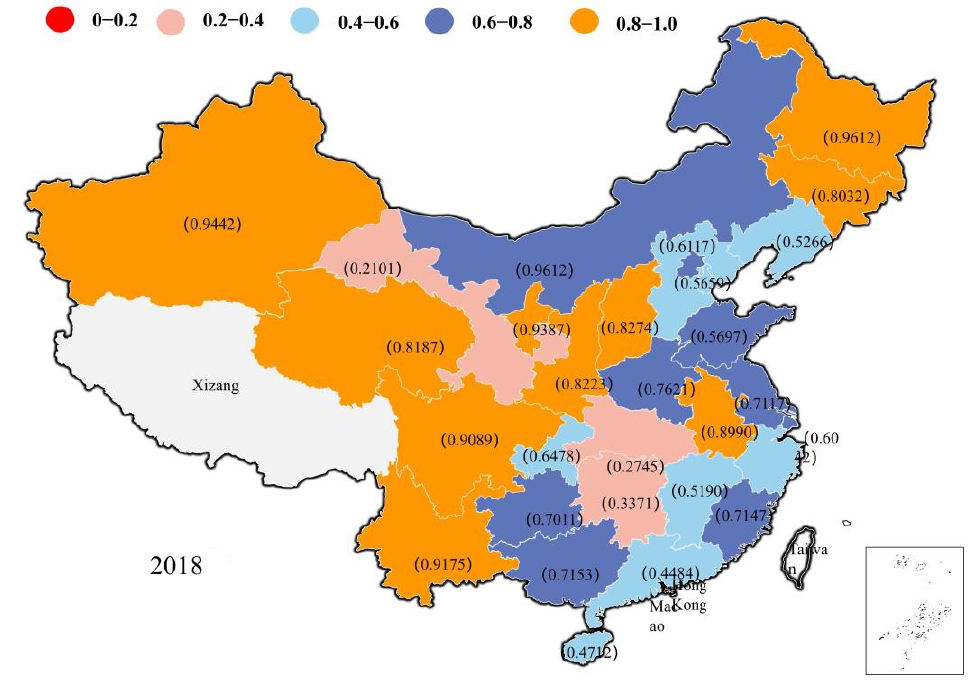
Figure 10. Spatial patterns of CERI scores in 2018 in 30 Chinese provinces.